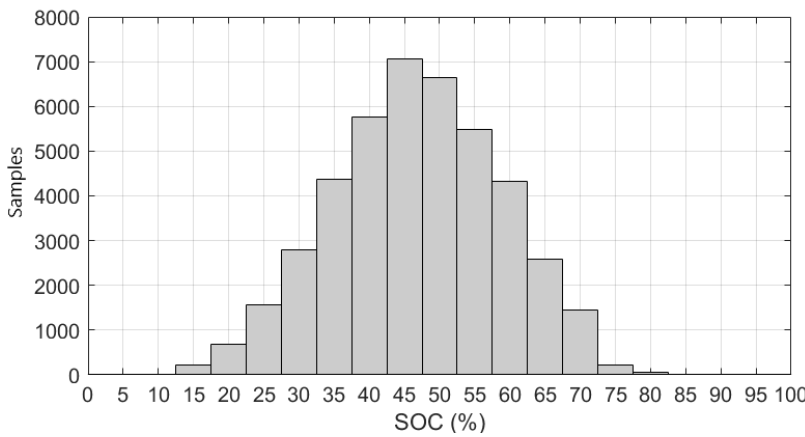
Figure 8. One hundred MW, 1 h BESS SoC for 18 GW of wind power